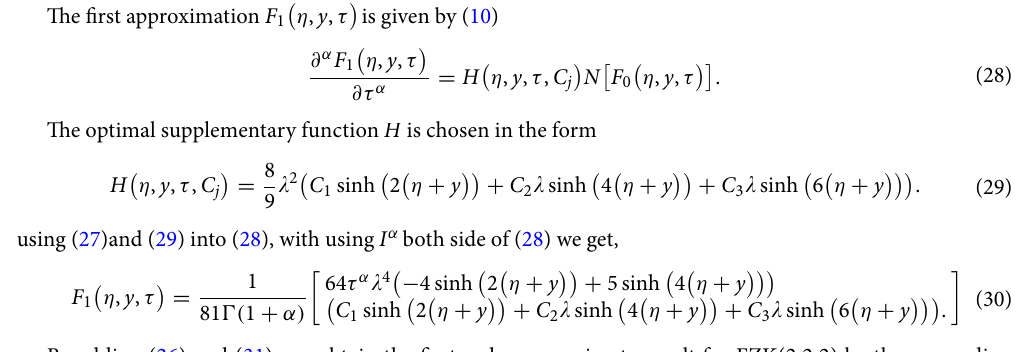
The optimal supplementary function H is chosen in the form